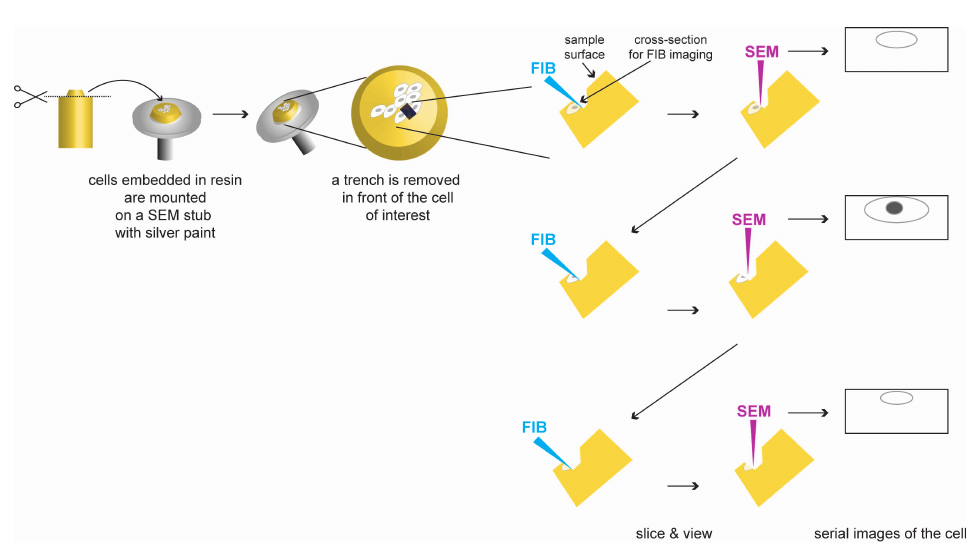
Figure 8. Principle of Focus Ion Beam (FIB)-Scanning Electron Microscopy (SEM). Epon blocks containing the embedded cells are mounted on SEM stubs with silver paint. First a trench is milled with the FIB, generating a cross-section into the epon block. Subsequently the newly generated block face is milled (with the FIB, blue), resulting in the removal of a thin layer (as small as 3 nm; [181]) and imaged (with the SEM, pink) in a sequential manner. This process is repeated automatically as long as needed to obtain a tomographic dataset. Further details about this method can be found in the main